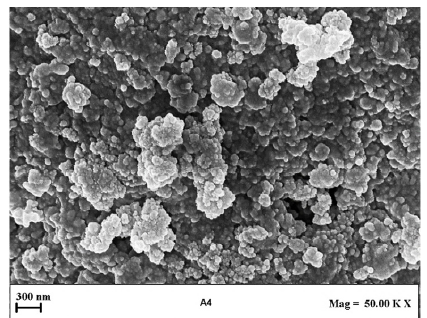
Figure 3. Representative FESEM images of liposomes produced at different Ab/Lipids and at a fixed WFR of 1 mL/min: ( A ) Sample with Ab/Lipids equal to 0% ( w / w ) and ( B ) Sample with Ab/Lipids equal to 0.625% ( w / w ). FESEM: field emission scanning electron microscope, Ab/Lipids: antibody ‐ to ‐ lipid mass ratio, WFR: water flow rate. Figure 5. Representative FESEM image of liposomes produced at Ab/Lipids equal to 0.625% ( w / w ) and at a fixed WFR of 10 mL/min. FESEM: field emission scanning electron microscope, Ab/Lipids: antibody ‐ to ‐ lipid mass ratio, WFR: water flow rate.